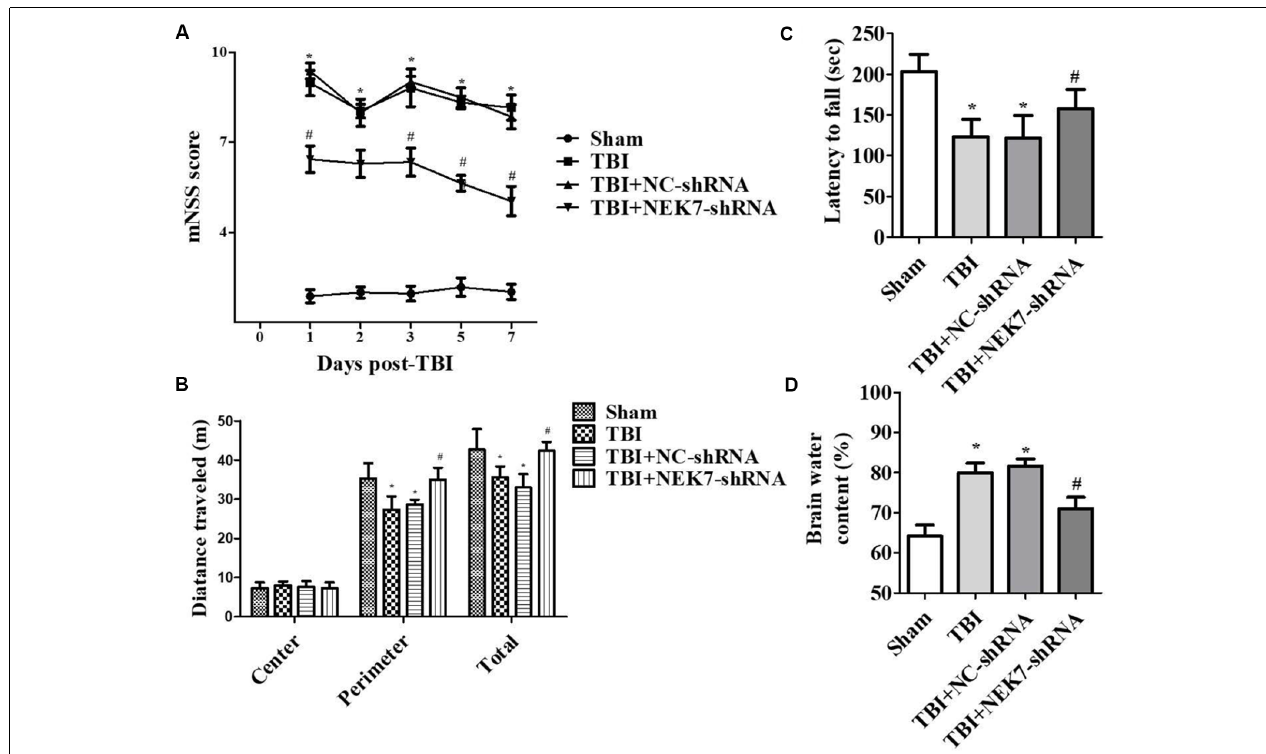
FIGURE 2 | NEK7 down-regulation attenuates neurological deficits and cerebral edema post-TBI. Experimenters were unaware of the TBI or sham treatments with mice. Neurological performances were assessed by the modified neurological severity scoring (mNSS; A ), the Rotarod test (B) , and the open-field test (C) . (D) The brain water content was detected following 48 h post-TBI. Data are represented as the means ± SEM, n = 11. ∗ p < 0.05, vs. sham. # p < 0.05, vs.